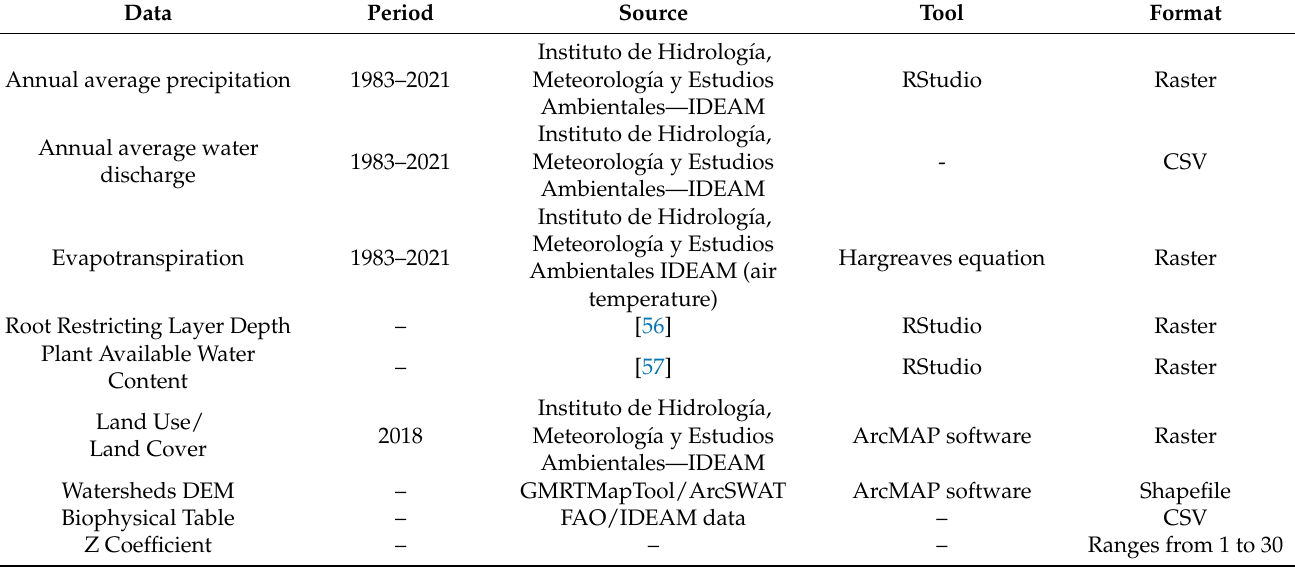
Table 1. Dataset used in the InVEST–AWY